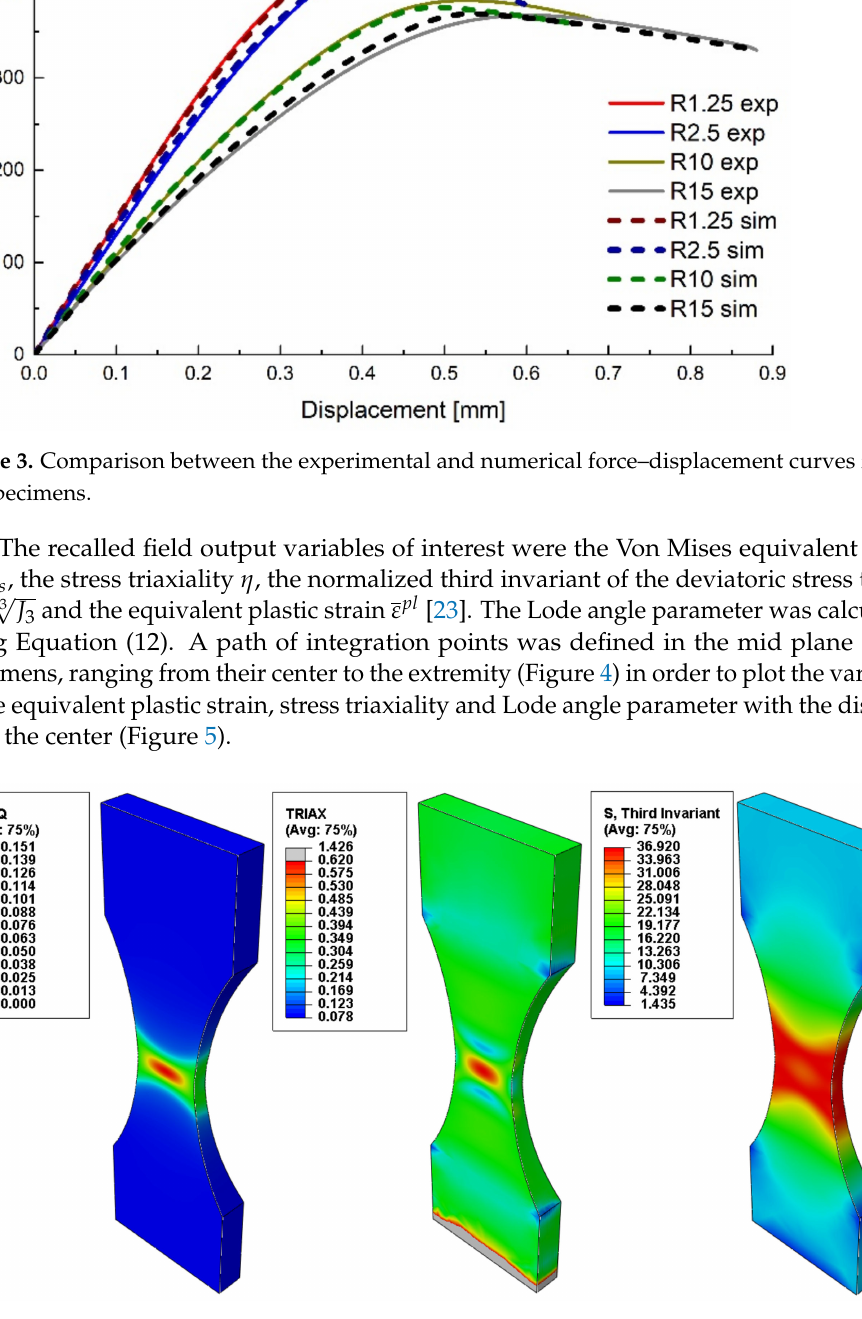
Figure 4. Equivalent plastic strain, stress triaxiality and normalized third invariant variation in the middle of the specimens for the 15 mm radius tensile